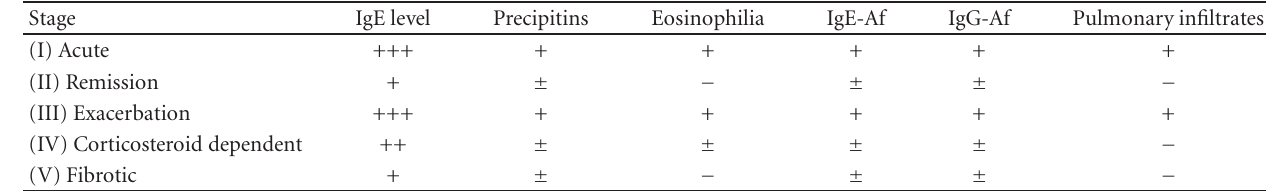
Table 3: Staging of allergic bronchopulmonary aspergillosis in